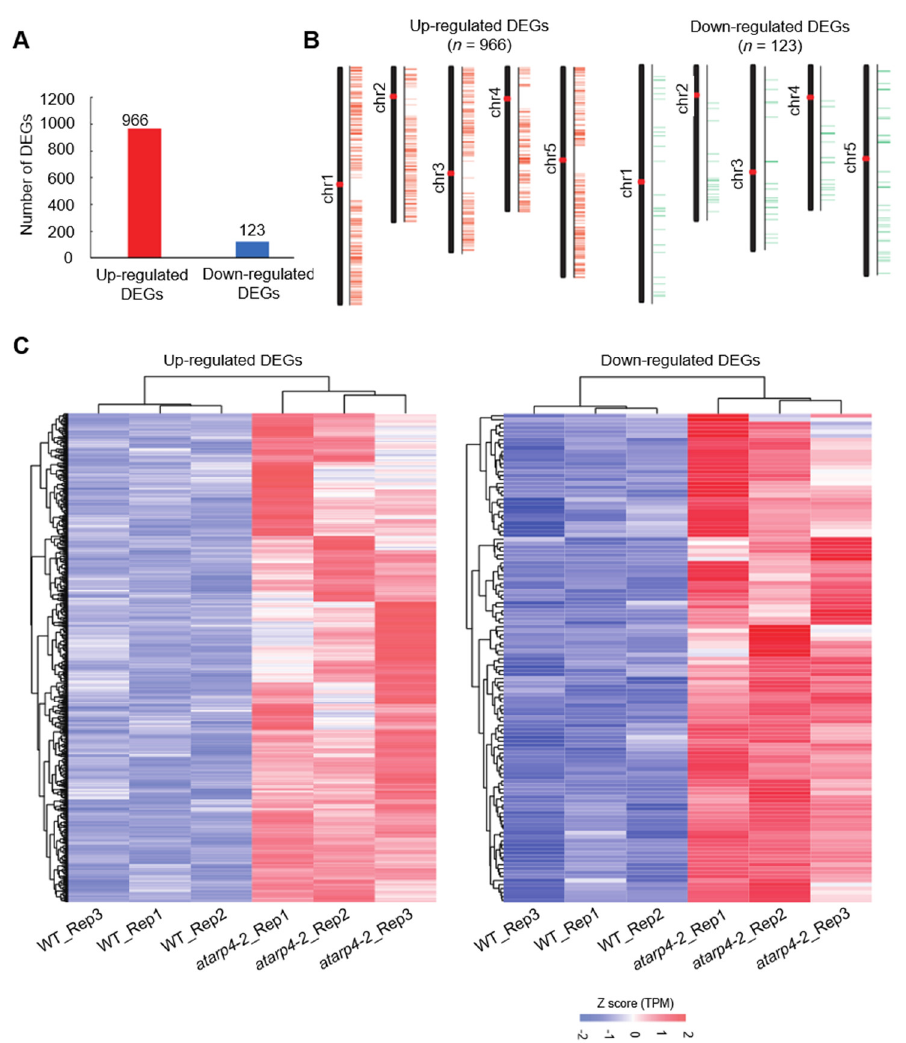
Figure 3. AtARP4 functions in regulating gene expression. ( A ) The number of up-regulated and down-regulated differentially expressed genes in atarp4-2 mutant. ( B ) The distribution of up-regulated DEGs (left panel) and down-regulated DEGs (right panel) at the five chromosomes of Arabidopsis genome. The schematic diagrams were generated by TBtools (Chen et al., 2020). ( C ) Heatmaps for AtARP4-dependent DEGs in WT and atarp4-2 plants. The heatmap was generated based on the trans per million (TPM) value.